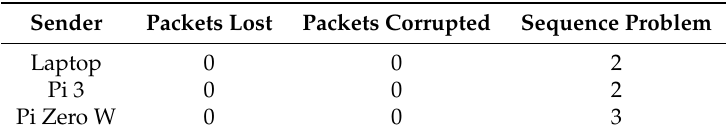
Table 5. Number of lost, corrupted or misplaced packets for over 10,000 sent when using the 1-kiB generated